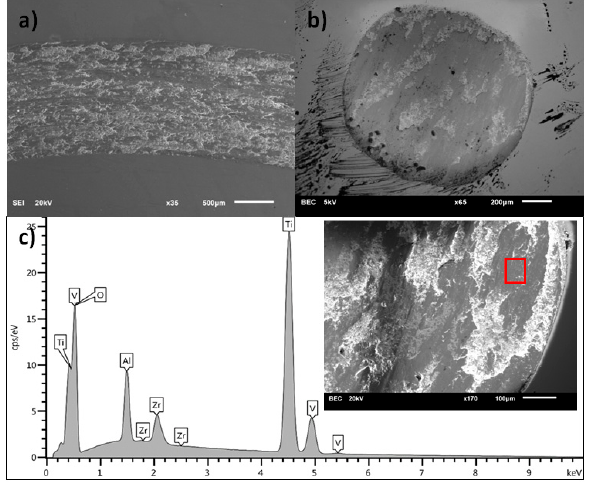
Figure 9. ( a ) Wear track on the surface of oxidized Ti-6Al-4V sample, ( b ) wear scar on the ZrO 2 ball surface, ( c ) the EDS analysis of the surface of ZrO 2 counterbody (inset with square shows the place of analysis).